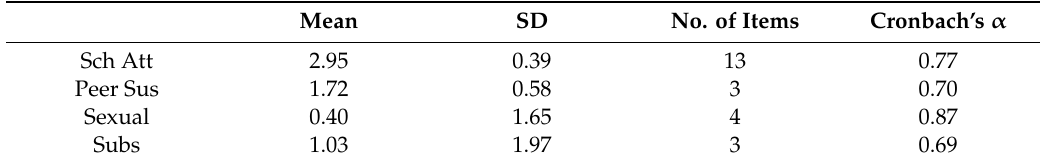
Table 2. Descriptive statistics, internal consistency reliability, and inter-variable correlations of measurement scales.